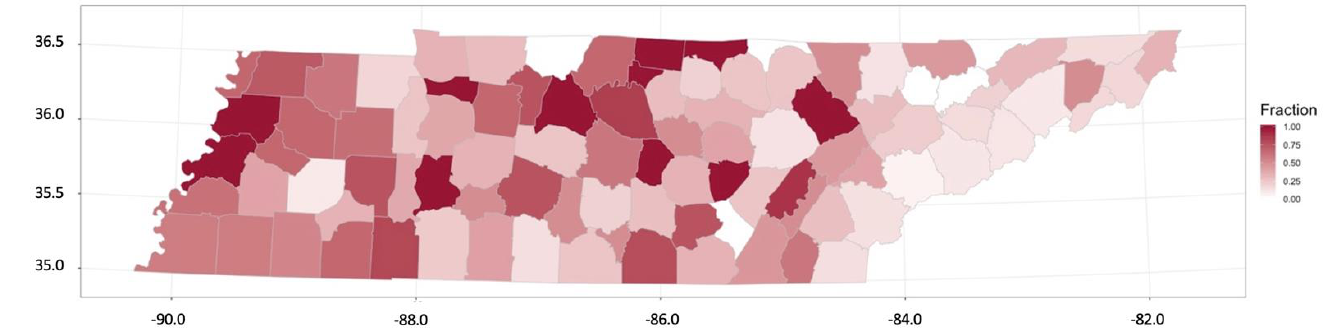
Figure 6. Spatial distribution of the systems with punctuated changes. Note: Intensity of the color represents the fraction: # of systems with punctuated changes . The MCL maps shows slight spatial # of systems in the same county clustering patterns (Moran’s I = 0.126, p -value = 0). The x axis is longitude, the y axis is latitude.